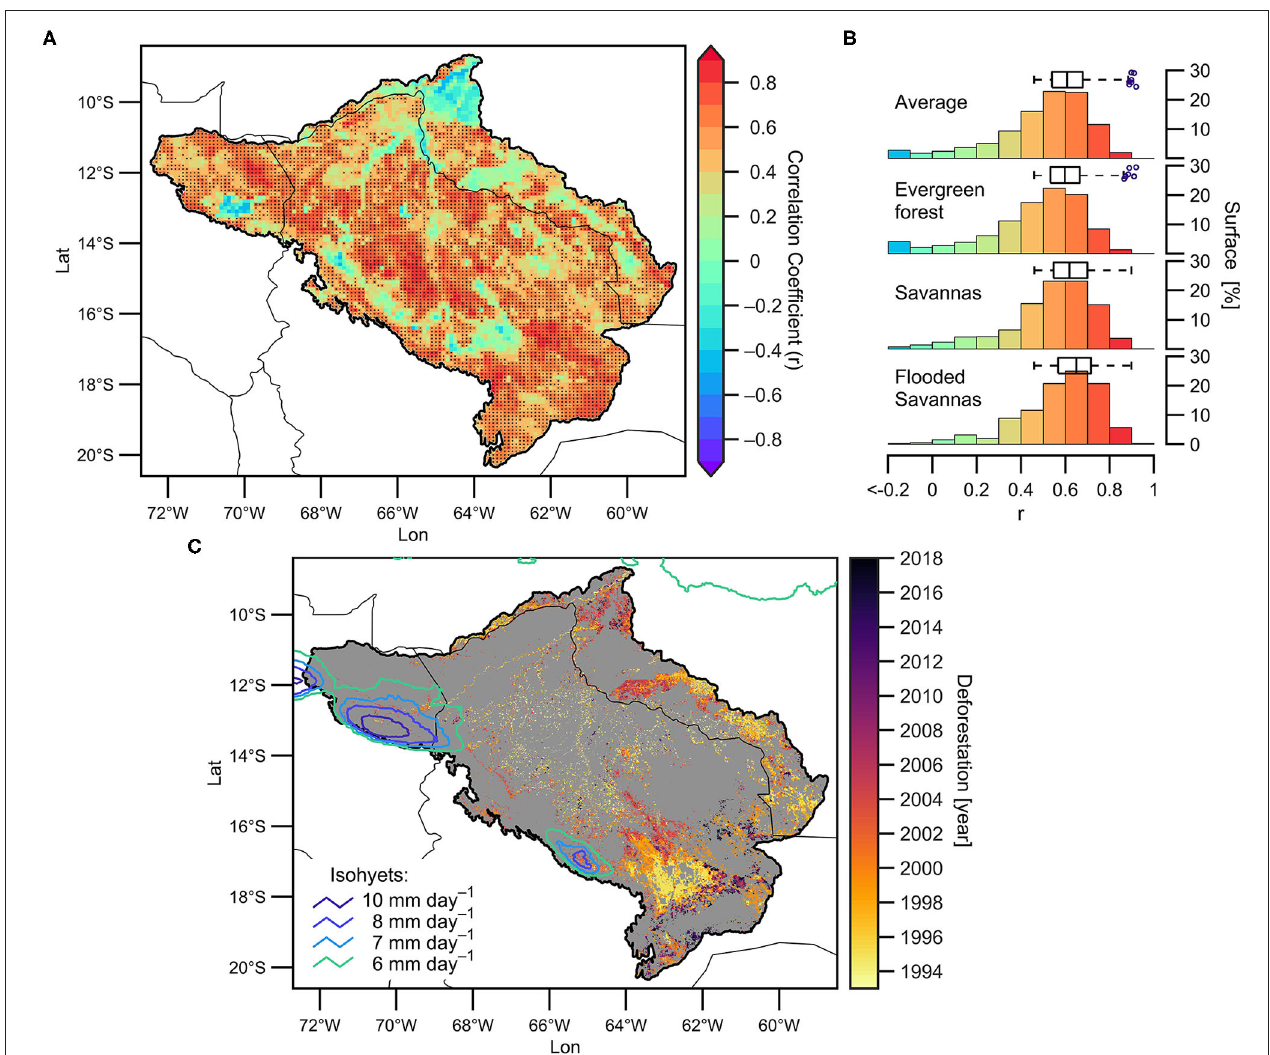
FIGURE 7 | (A) 2000–2019 spatial correlation (0.05 ◦ spatial resolution) between precipitation averaged over the upper Madeira Basin during the PDS and NDVI anomalies in each grid point during the VDS ( p < 0.05 are displayed with a dark dot). (B) Bars represent the surface (in percentage) in different correlation ranges for the basin average and for each predominant cover type. Boxplots indicate significant correlation ranges ( p < 0.05) computed in (A) . (C) Map of deforestation (at 300m spatial resolution; colors indicate the year of deforestation between 1993 and 2018 period) and annual average precipitation (lines, in mm day − 1 for the 1981–2019 period). Only isohyets above 6mm day − 1 are shown. Grey shades indicate regions that have not been deforested during the 1993–2018